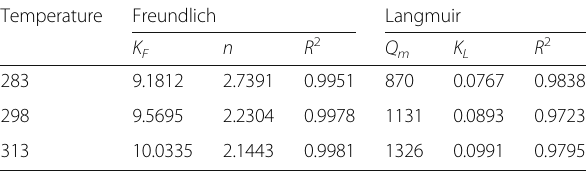
Table 2 Adsorption isothermal parameters fitted with Freundlich and Langmuir models